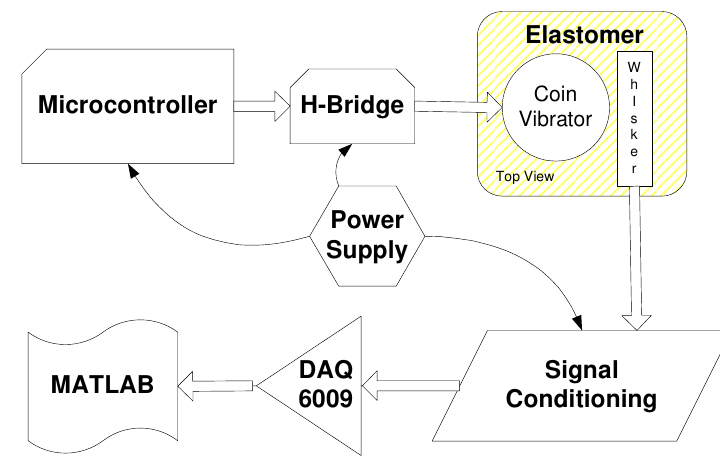
Figure 2. The block diagram of the overall system. The microcontroller adds the ability of controlling the oscillation frequency of the coin vibrator, therefore giving the ability to mimic the natural